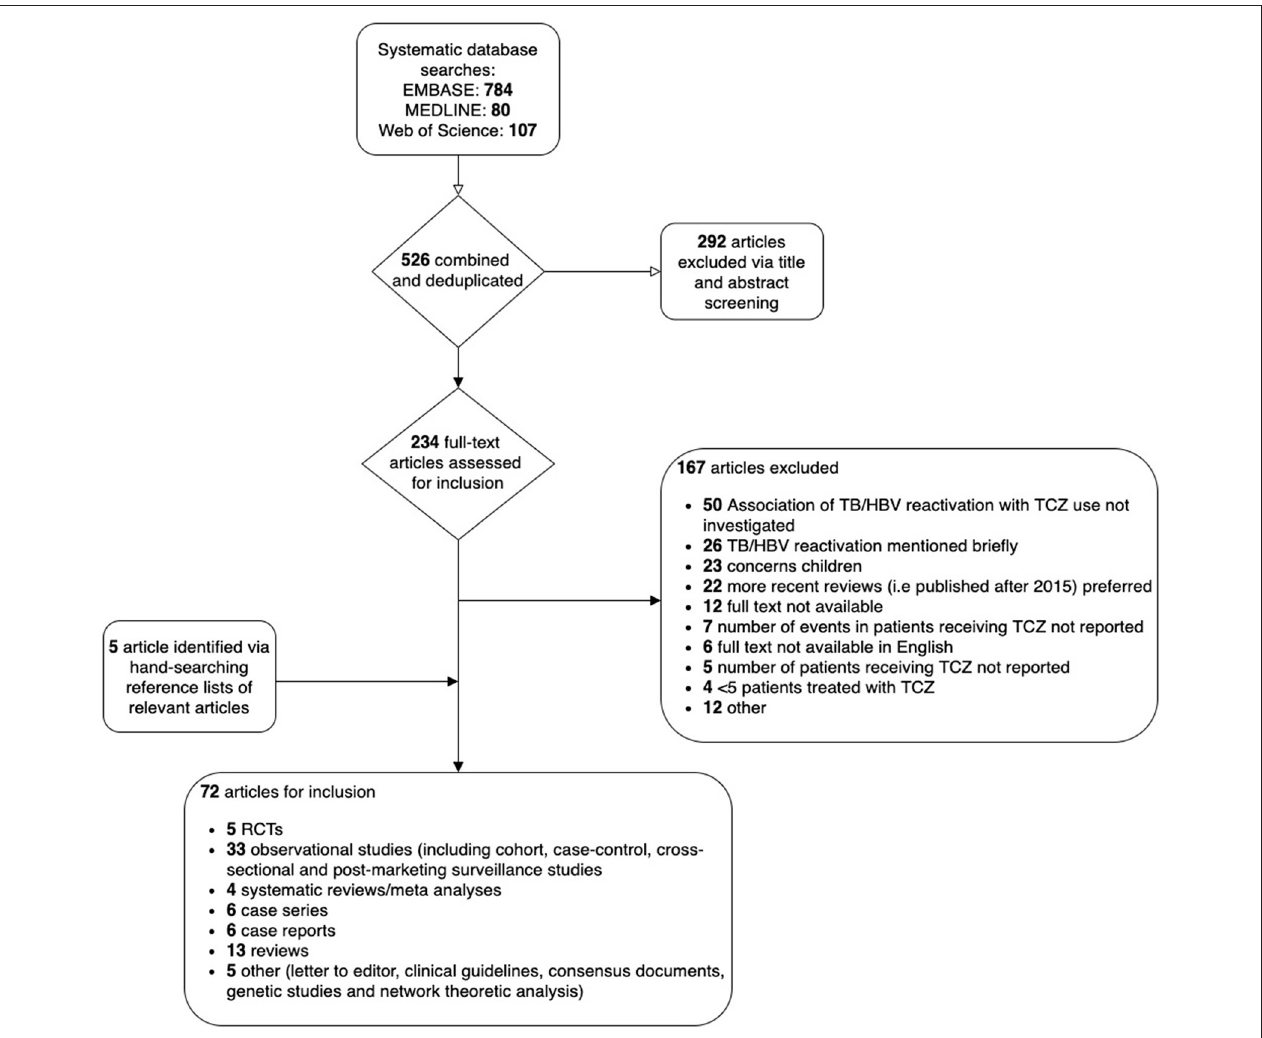
FIGURE 3 | Flow chart to show selection of studies reporting the risk of HB and/or TB reactivation in patients treated with tocilizumab (TCZ) from a systematic literature